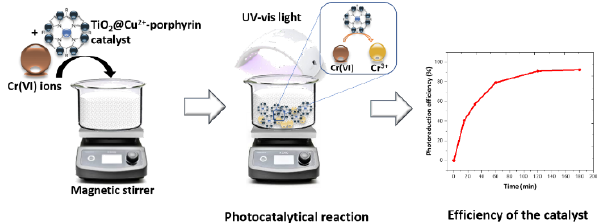
Scheme 1. Schematic diagram for the adopted experimental setup and analytical responses obtained for the conversion of Cr(V) ions by using TiO 2 or TiO 2 -porphyrin based